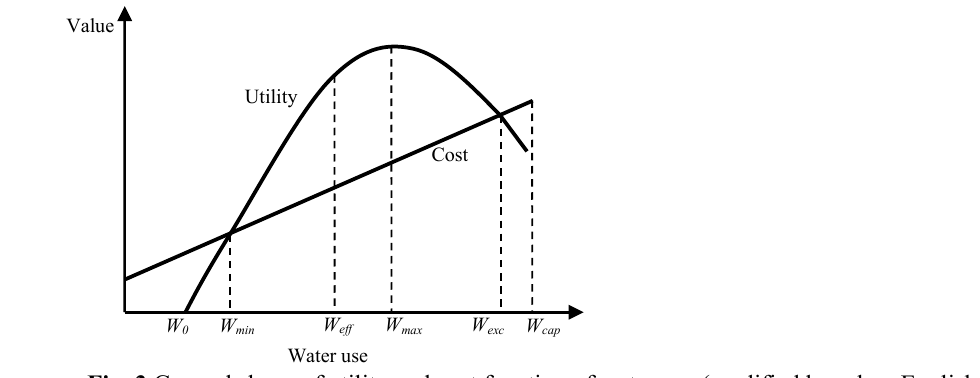
Fig. 3 General shape of utility and cost function of water use (modified based on English